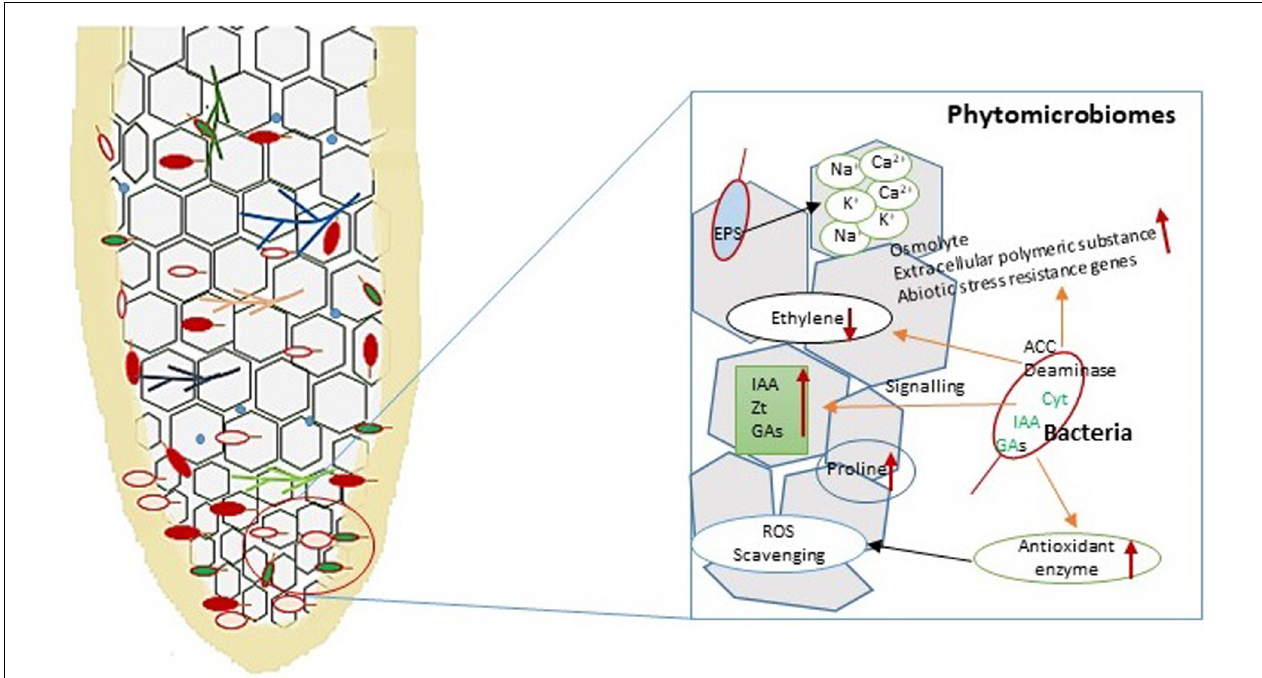
FIGURE 6 | Diagrammatic representations of plant–microbe interaction in the root and their different functions under salinity stress. Bacteria produce signaling molecules that help to support plant growth and development under stress conditions. Under salinity stress, bacterial the enzyme ACC deaminase reduces ethylene synthesis and enhances indole-3-acetic acid (IAA), Zeatin (Zt), and gibberellins (GA) in the plant. Exopolysaccharides (EPS) secreted by bacteria bind with different ions (Ca 2 + , K + , and Na + ) to prevent their effects on the plant. Endophytic bacterial strains induce antioxidants for controlling reactive oxygen species (ROS) generation in the plant under abiotic stress